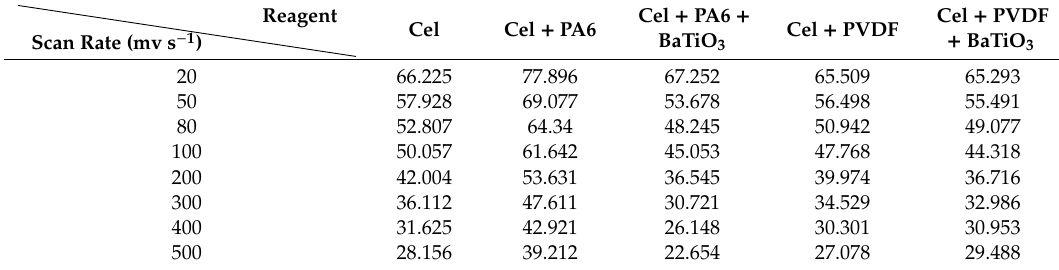
Table 1. Specific capacitance values of di ff erent friction layers at di ff erent scanning rates.